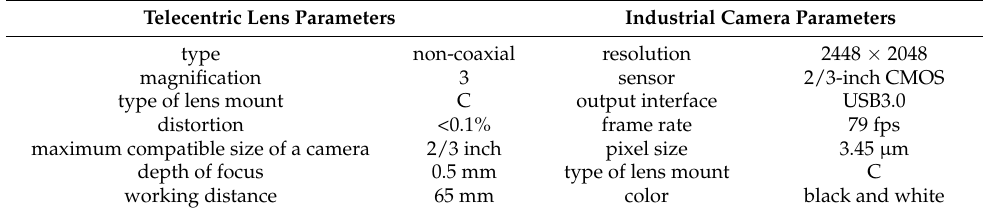
Table 3. Parameters of industrial camera and telecentric